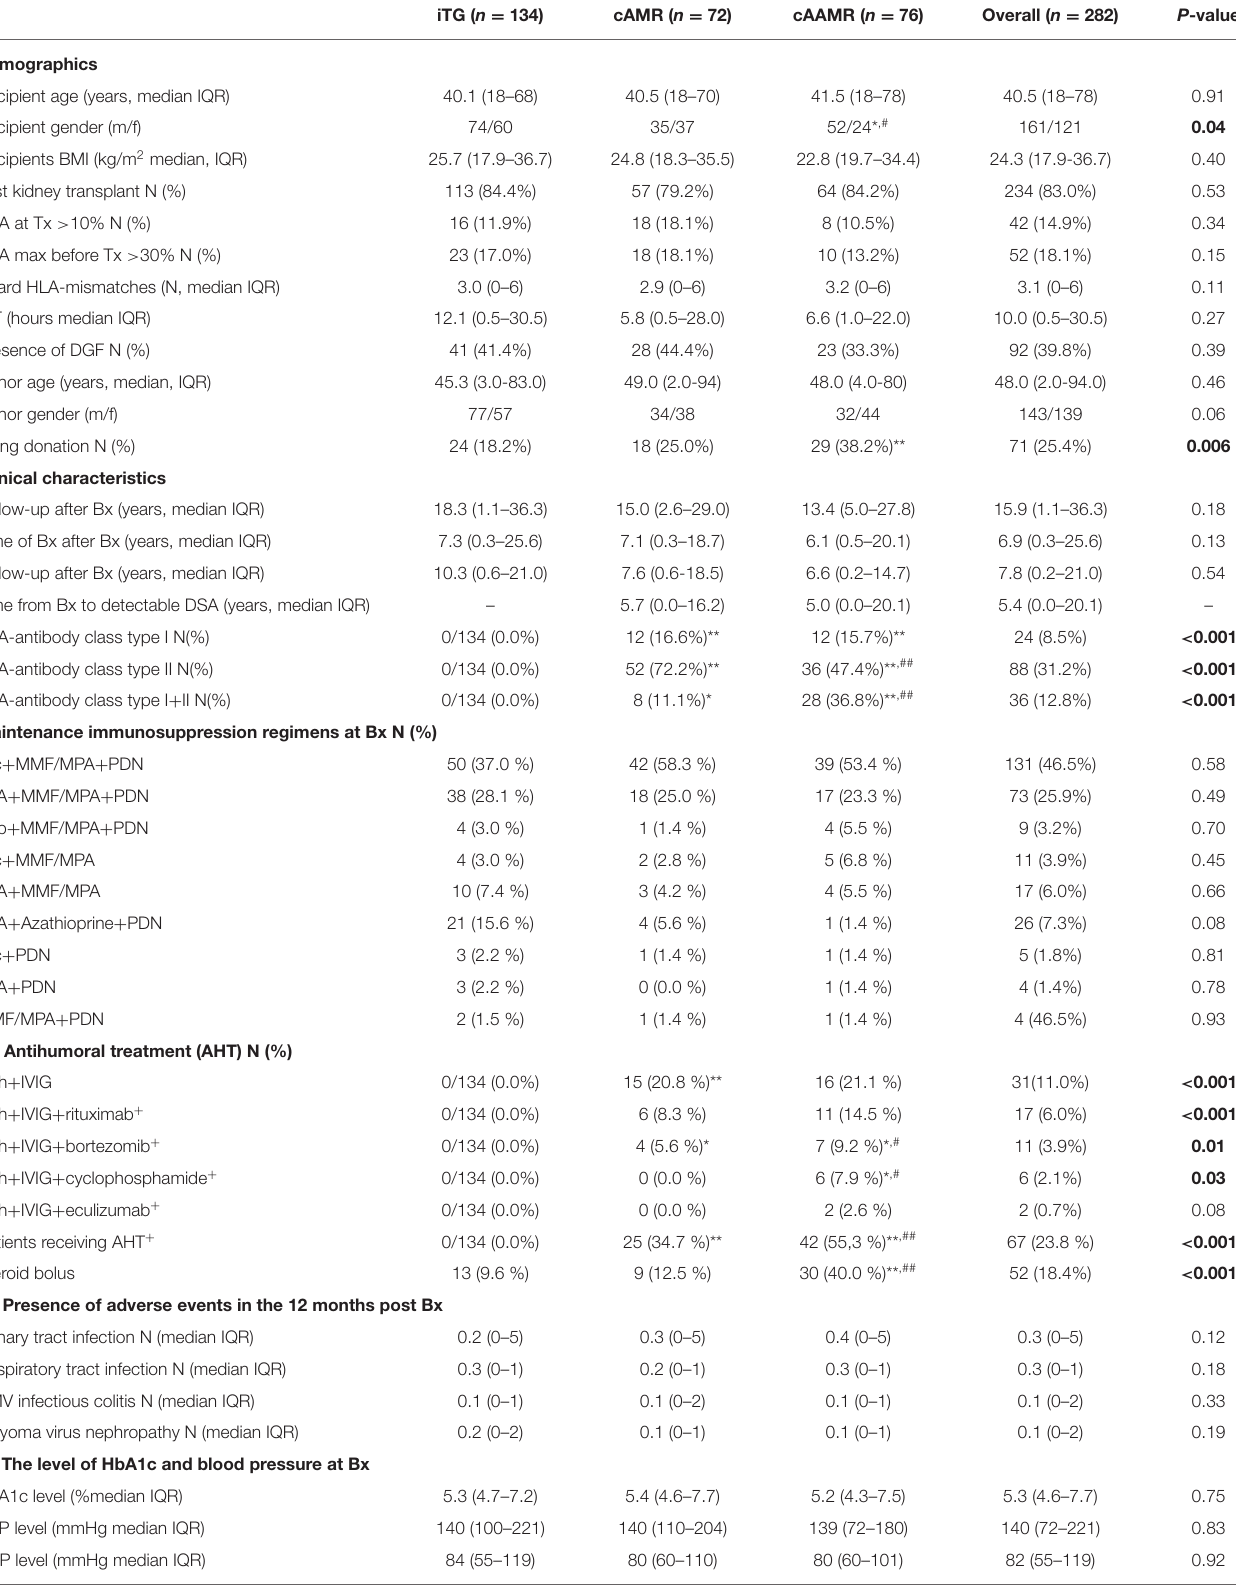
TABLE 1 | Demographics and clinical